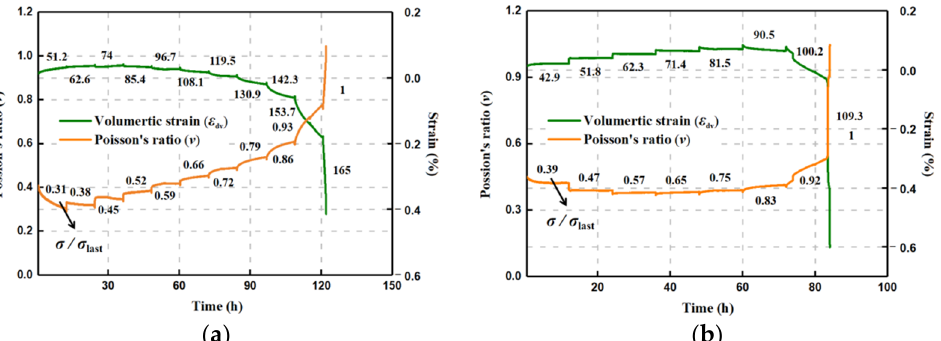
Figure 5. Time-dependent evolution of Poisson’s ratio and volumetric strain of quartz sandstone under dry and saturated conditions. ( a ) Dry specimen. ( b ) Saturated specimen.